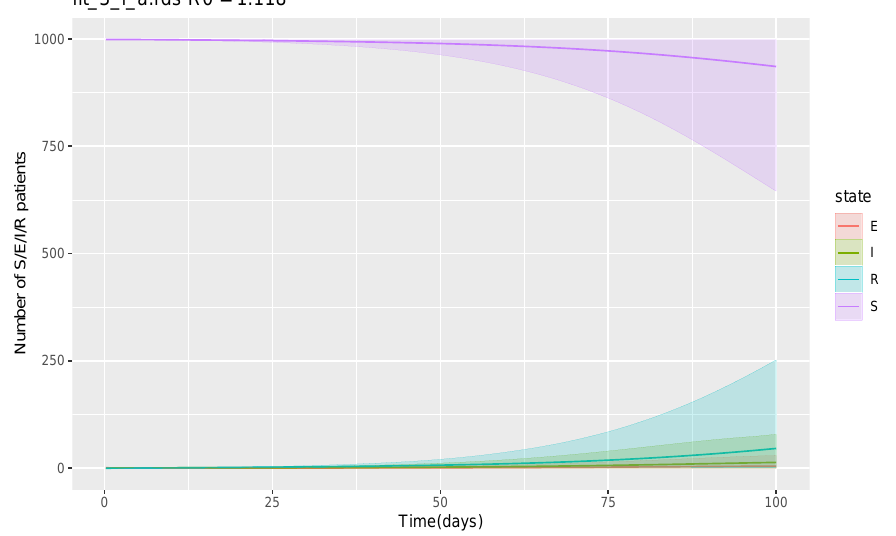
Figure 3. SEIR model with the parameters ( β 0.1–0.2, δ 1 / 4–1 / 2, and ν 1 / 10–1 / 7) when the secondary outbreak started to occur. Abbreviations S = susceptible, E = exposed, I = infected, and R = recovered and removed.